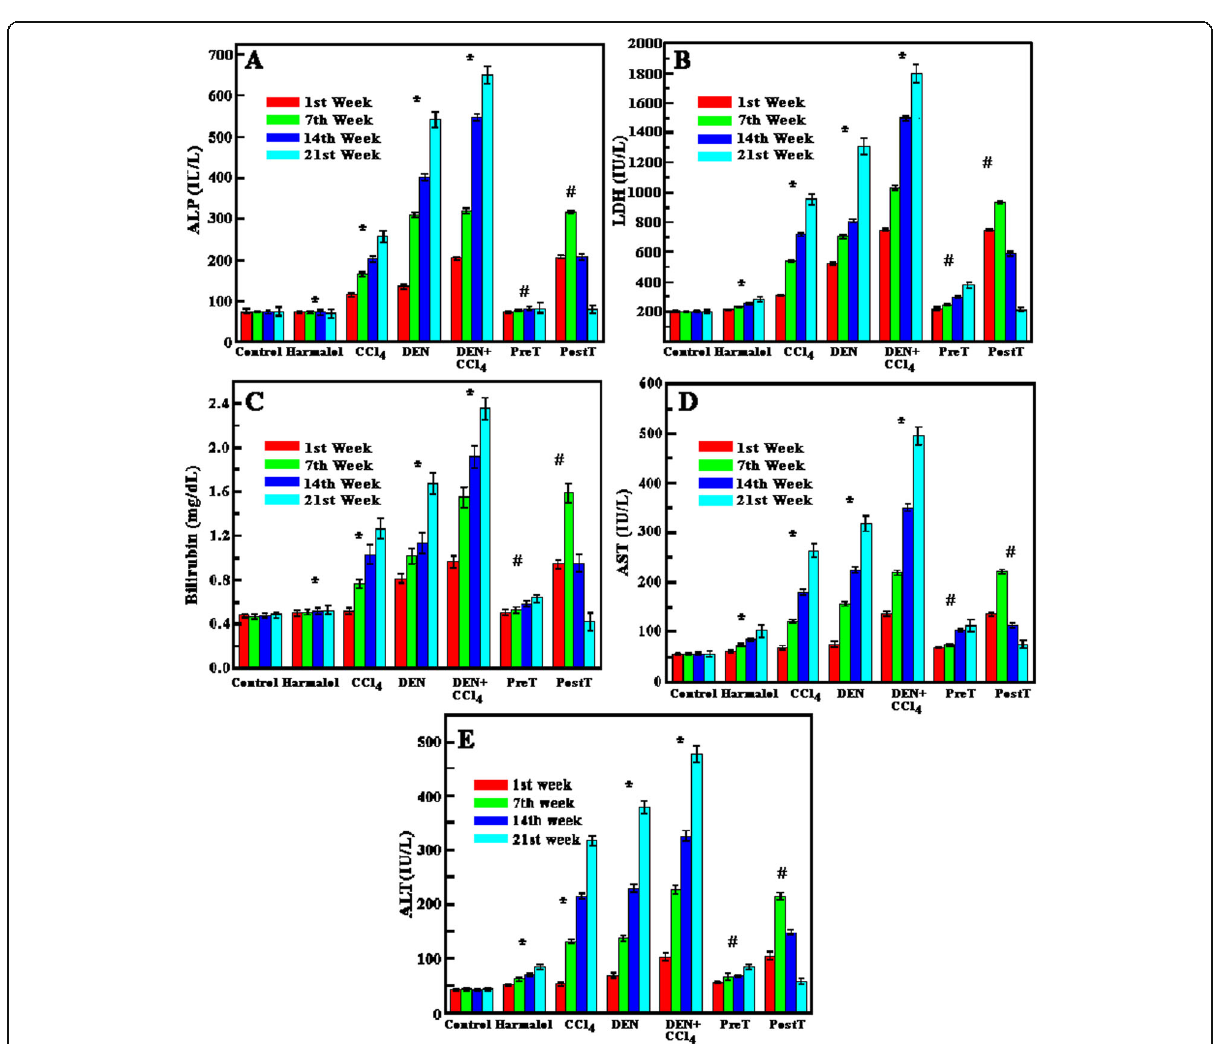
Fig. 4 Bar graph representation showing the effect of carcinogen (DEN+ CCl 4 ) and harmalol treatment on experimental mice by measuring the serum level of liver functional enzymes. a ALP, b LDH, c bilirubin, d AST, and e ALT after different time period. Control, harmalol-treated (total 80